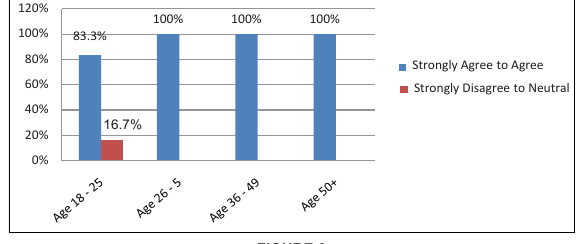
FIGURE 9 Internet banking maturity or growth – per age category